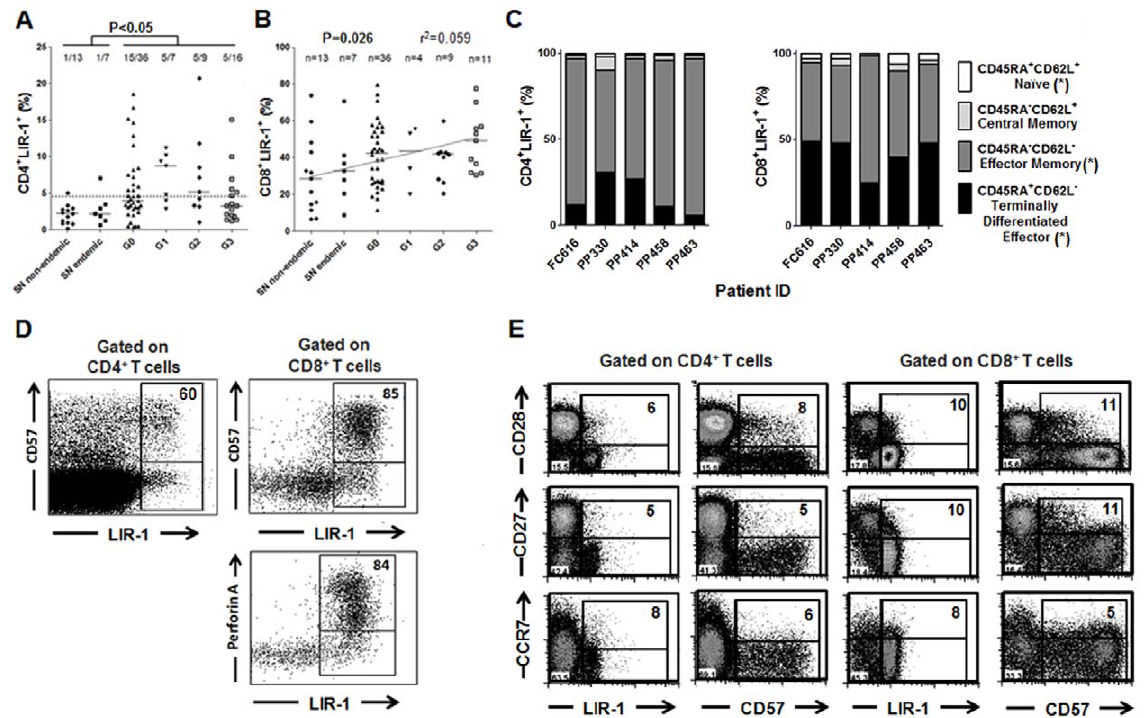
Figure 3. Frequencies of total LIR-1 + T cells in the circulation of chronically T.cruzi -infected subjects and uninfected controls. PBMCs were isolated by density gradient centrifugation on ficoll-hypaque and stained with anti-CD4, anti-CD8 and anti-LIR-1 monoclonal antibodies. Each point represents the percentage of CD4 + LIR-1 + (A) and CD8 + LIR-1 + (B) T cells in individual subjects. SN non-endemic: subjects with negative serology who had not lived in areas endemic for T. cr uzi infection; SN endemic: subjects with negative serology born in endemic areas; G0, G1, G2 and G3: clinical groups of chronically infected subjects as defined in Material and Methods. Median values are indicated by the horizontal lines. A cut off value for CD4 + LIR-1 + T cells (dotted line) was set as the mean percentage 6 2SD from uninfected subjects. The number of subjects with values above the cut off out of the total number of subjects evaluated is shown. A positive trend in the percentages of CD8 + LIR-1 + T cells as disease becomes more severe is also shown. (C) Expression patterns of LIR-1 in total CD4 + CD8 + T cells. PBMCs from 4 G0 (FC616, PP414, PP458 and PP463) and 1 G1 (PP330) patients were stained with anti-CD8, anti-CD45RA, anti-CD62L and anti-LIR-1 monoclonal antibodies. The bars represent the percentages of LIR-1- expressing naı¨ve, effector, effector memory and central memory CD4 + (left panel) and CD8 + (right panel) T cells out of total CD4 + LIR-1 + or CD8 + LIR-1 + T cells. (*) P , 0.05 between CD8 + and CD4 + T cells for the corresponding T cell compartment expressing LIR-1. The percentages of (D) Representative perforin A and CD57 expression profiles by CD4 + LIR-1 + (upper panel) or CD8 + LIR-1 + (bottom panel) T cells. The percentages in the upper right quadrants show the expression of perforin A (left panel) and CD57 (right panel) by CD4 + LIR-1 + or CD8 + LIR-1 + T cells. Representative CD28 (top panel), CD27 (middle panel) and CCR7 (low panel) expression profiles by CD4 + LIR-1 + (left panel) or CD4 + CD57 + (right panel) (E), and CD8 + LIR-1 + or CD8 + CD57 + (F) T cells. The percentages in the upper right quadrants show the expression of the indicated molecules by CD4 + LIR-1 + or CD8 + LIR-1 + T and CD4 + LIR-1 + or CD8 + CD57 + T